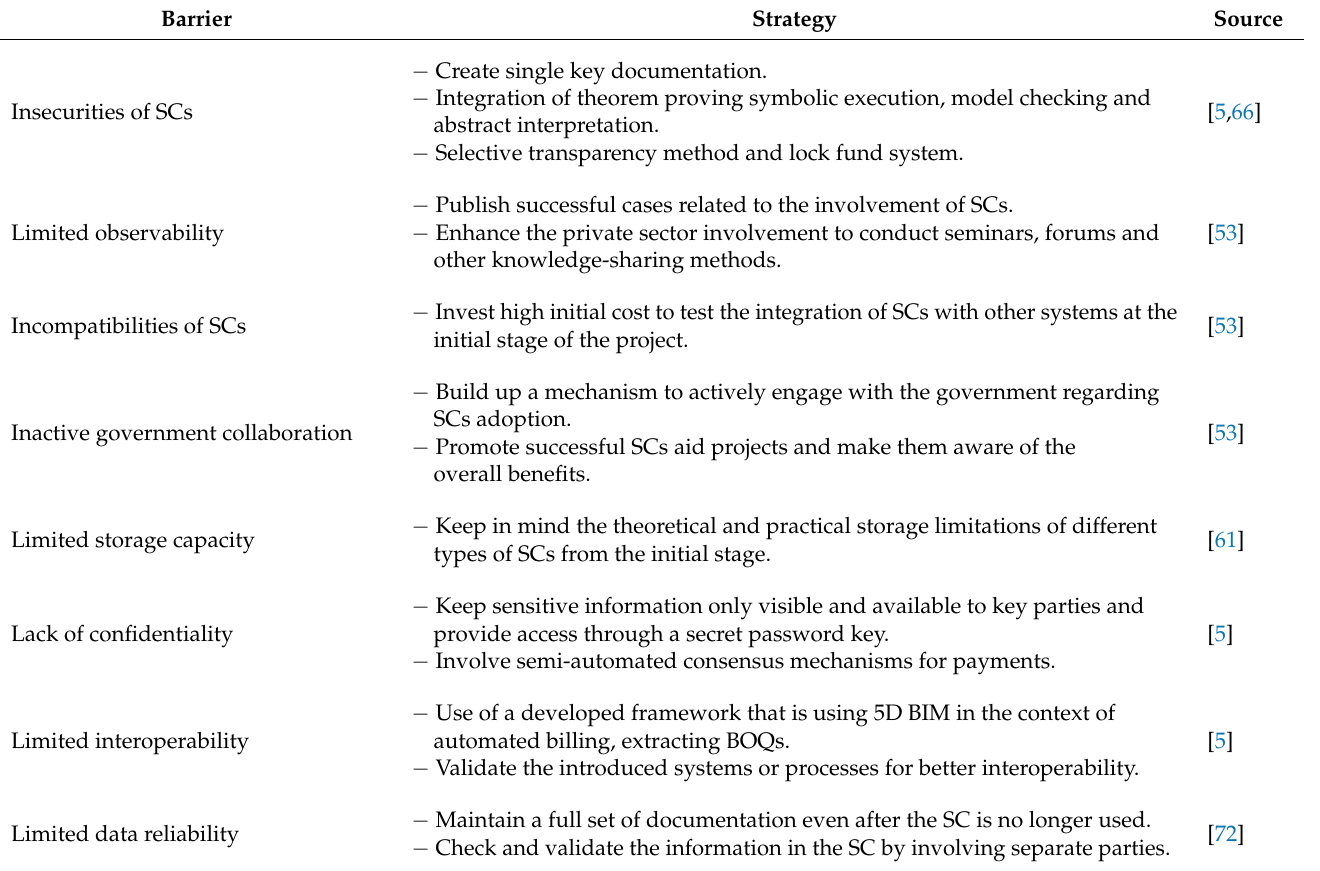
Table 6. Barriers and Strategies to Overcome the Identified Barriers of Adopting SCs in the Construc- tion Industry. Strategy